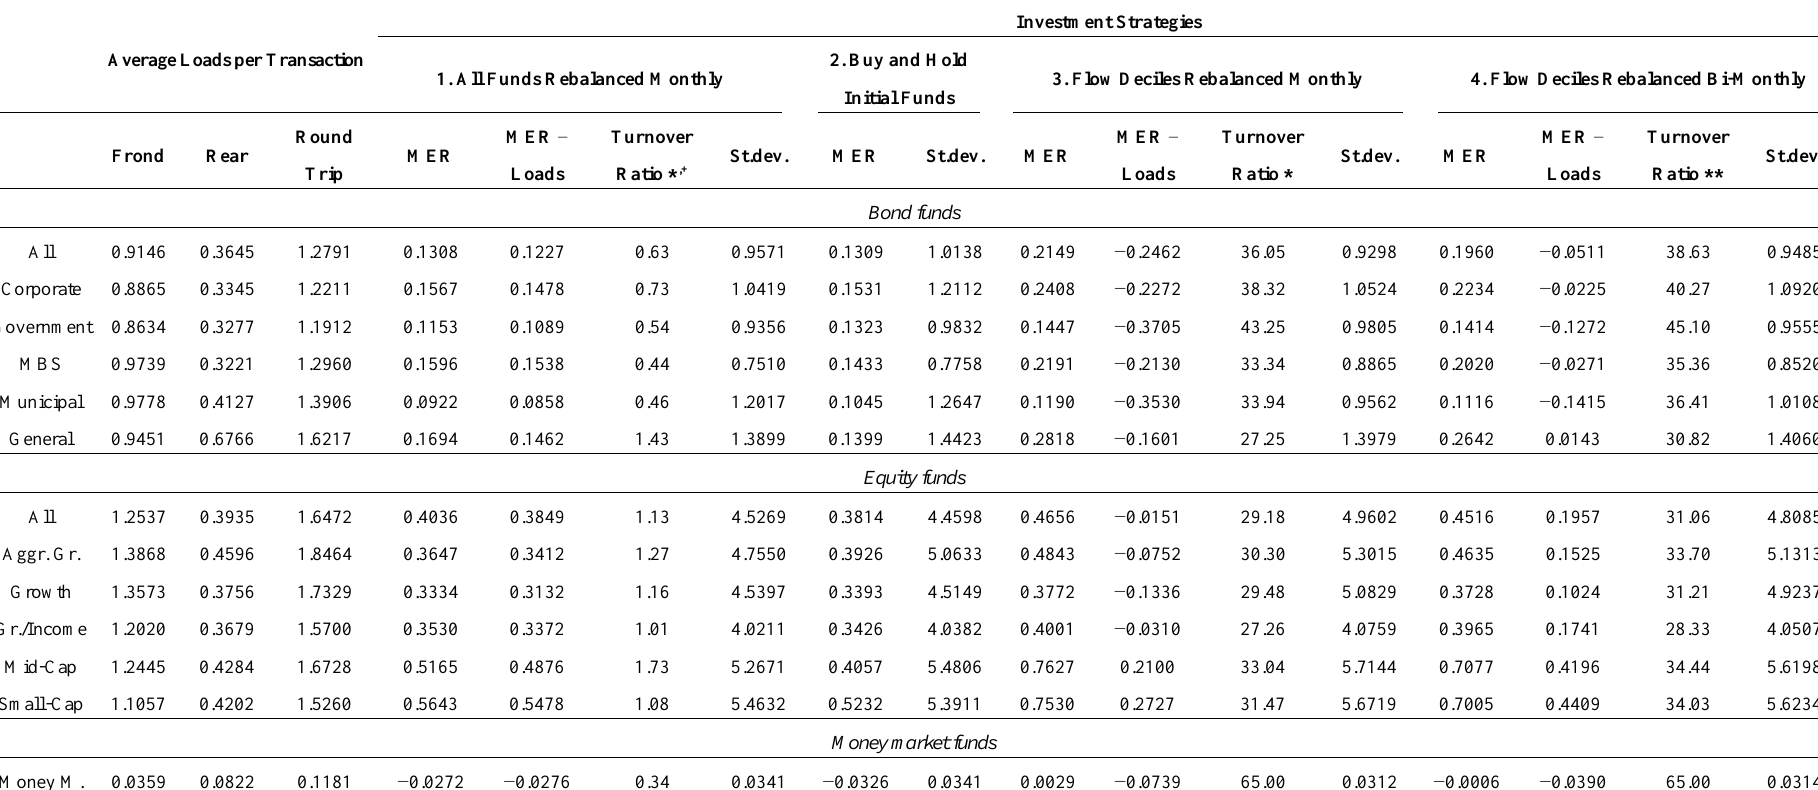
Table 8. Returns to different investment strategies and